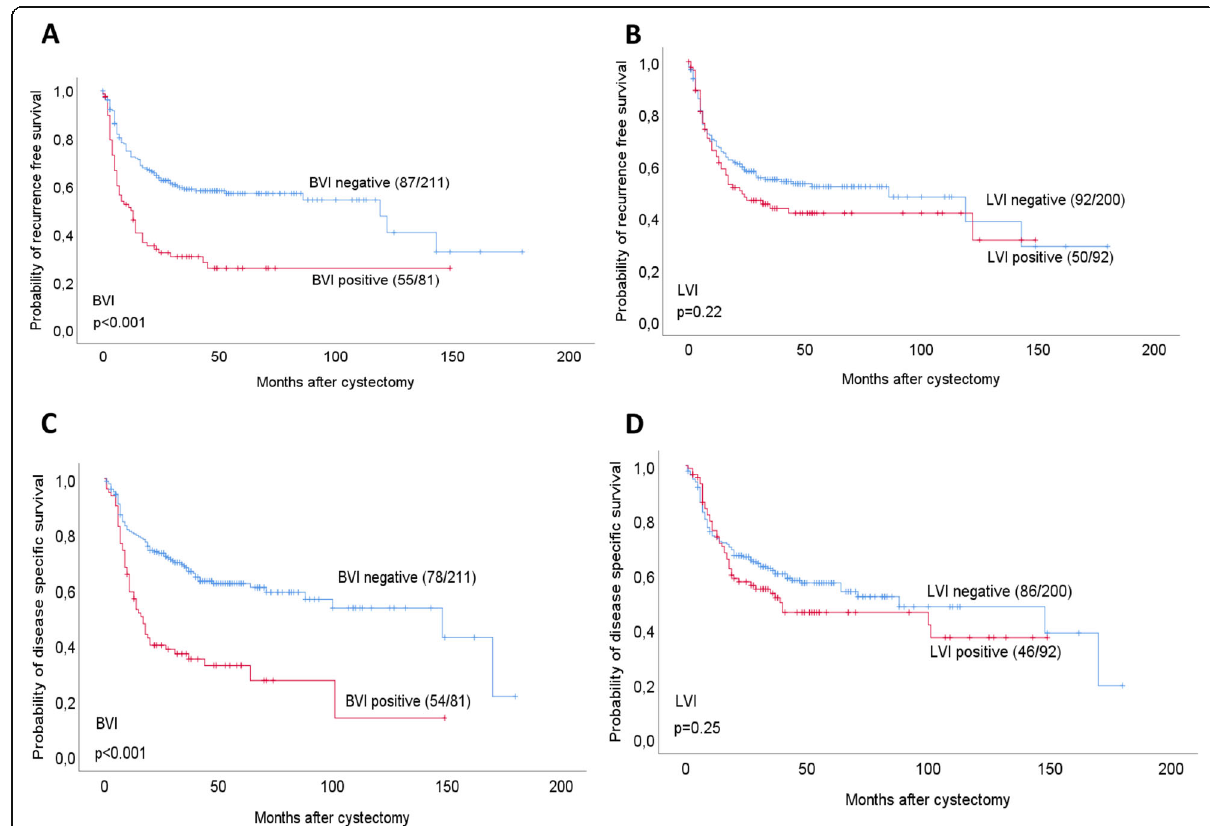
Fig. 2 Recurrence free and disease specific survival related to BVI ( A , C ) and LVI ( B , D ). Footnotes: Survival curves are estimated by the Kaplan Meier method using the log-rank test for differences between subgroups. For each category, number of events/total number of cases are